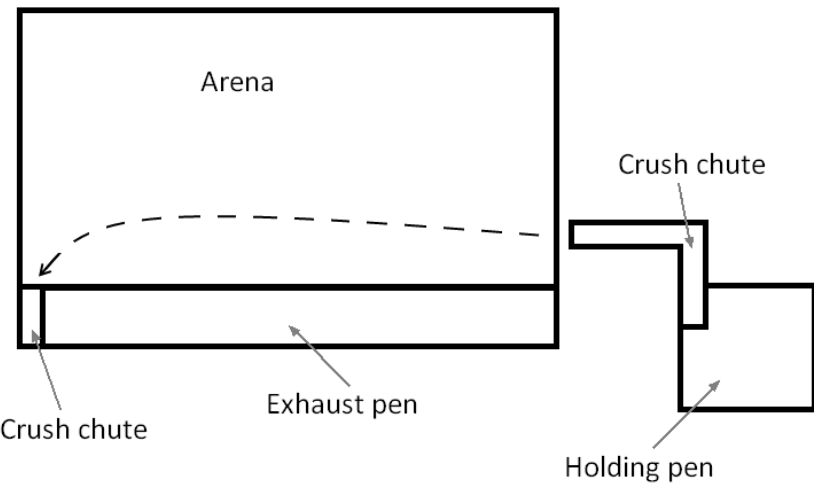
Figure 1. Test facility, with holding pen, crush chutes and exhaust pen for return to holding pen or paddock, together with the route taken by Naïve Marshalled (NM) calves.